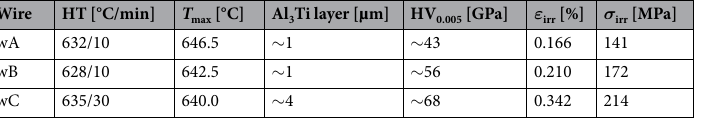
Table 1. Heat treatment conditions with initial short temperature overshoot ( T max ) of wires wA-wC and the corresponding Al 3 Ti interface layer thickness, the HITEMAL sheath micro-hardness (HV 0.005 ), the irreversible strain ( ε irr ) and stress ( σ irr